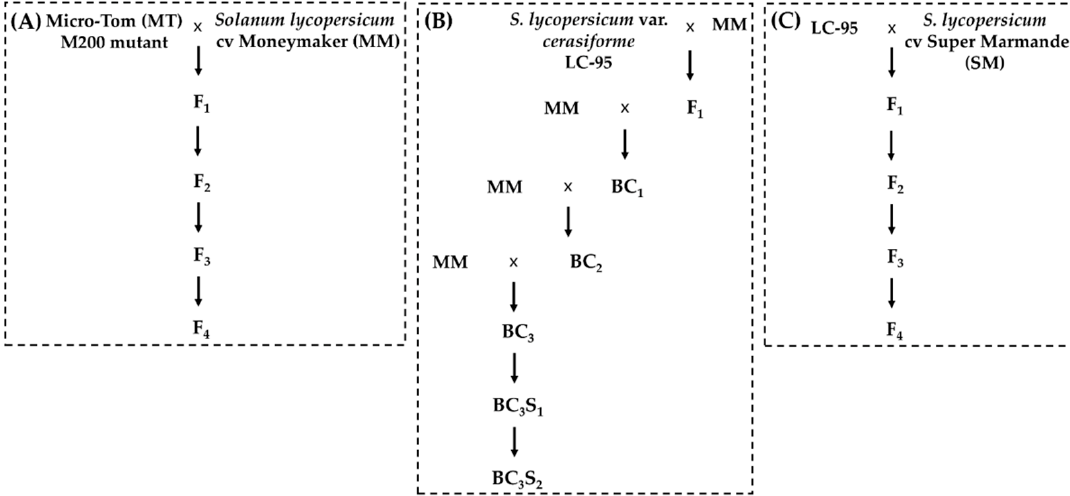
Figure 1. Pedigree scheme of ( A ) F 4 plants homozygous for the m200 allele, ( B ) BC 3 S 2 lines homozygous for the ol-2 allele in Solanum lycopersicum cv. Moneymaker background ( ol-2 _MM) and ( C ) F 4 plants carrying the ol-2 allele in cv. Super Marmande background ( ol-2 _SM).